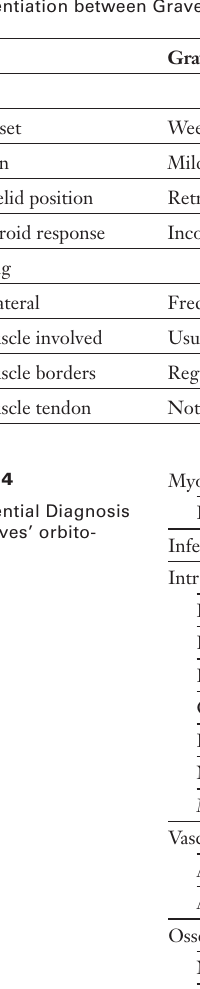
Differentiation between Graves’ orbitopathy and orbital myositis [9].